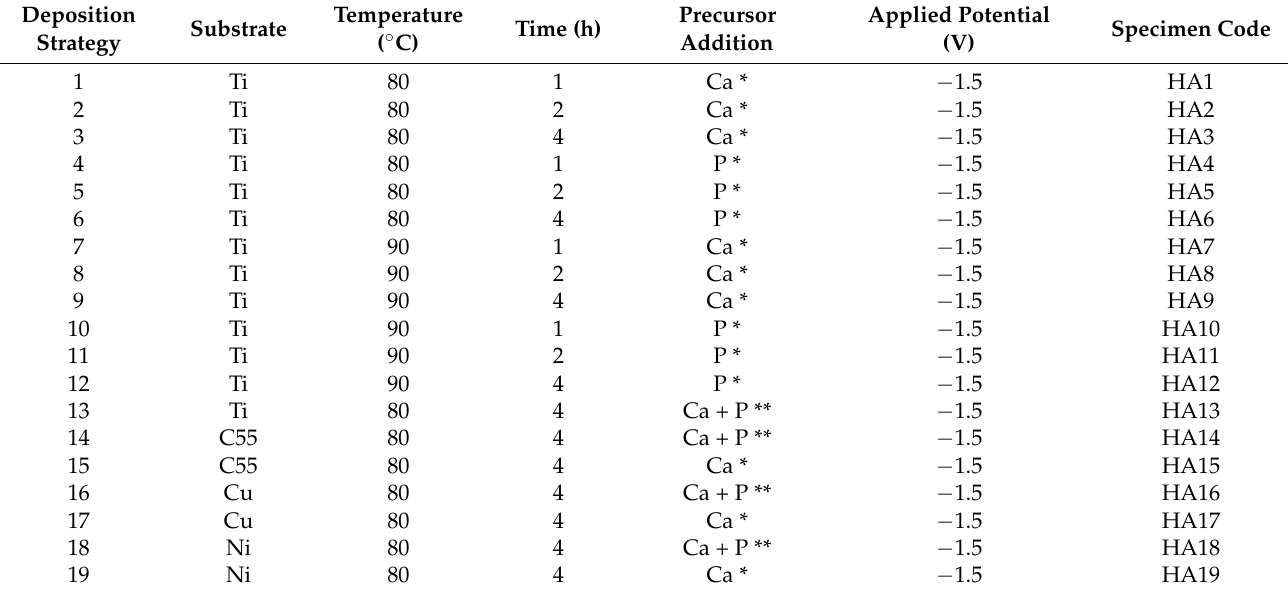
Table 1. Electrodeposition strategies used to obtain the HA